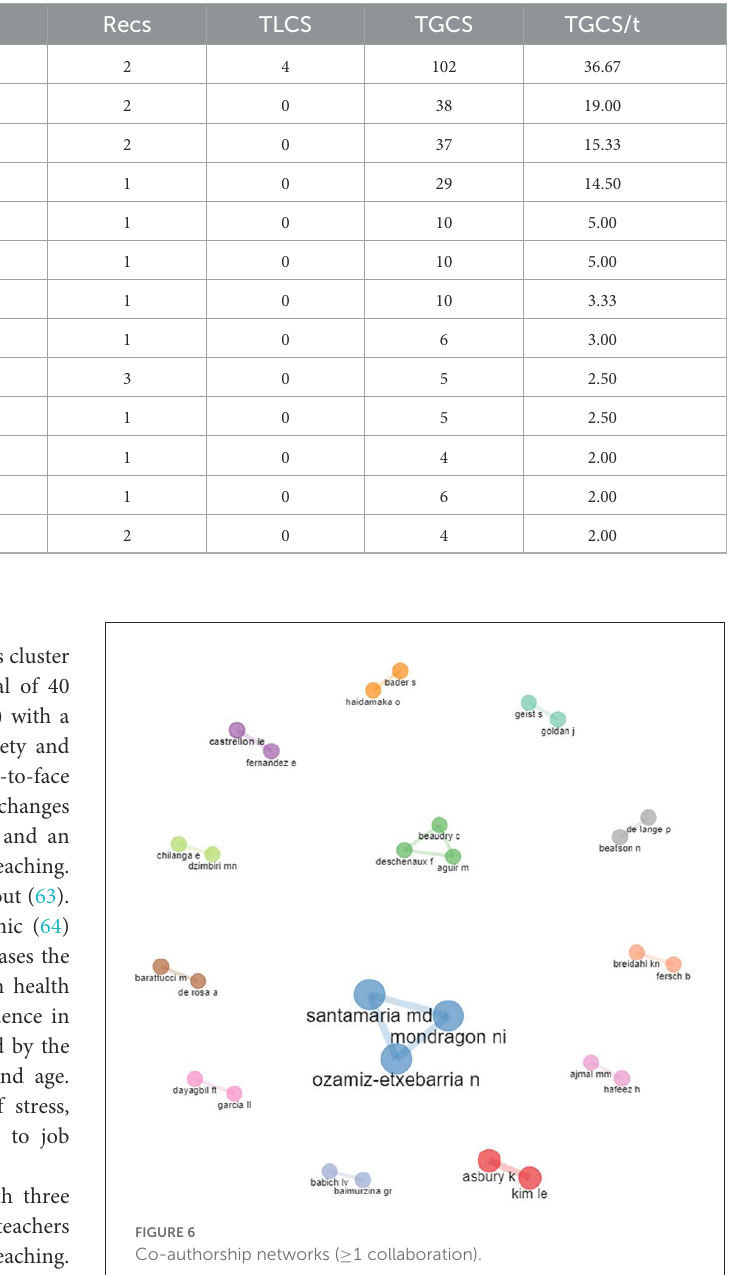
TABLE 3 Journals by the number of total global citations per year (TGCS/t) ( ≥ 2 TGCS/t).